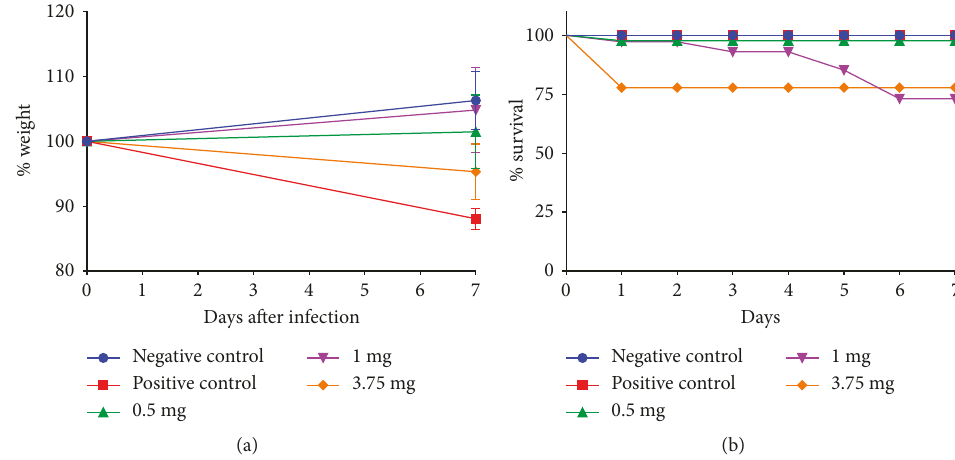
Figure 2: Graph of weight change and survival in infected mice: (a) graphic representation of the body weight (g) of C57BL/6 mice after 7 days postinfection with volcanic ash at concentrations of 0.5mg (green), 1mg (purple), and 3.75mg (orange); negative control (PBS, blue); and positive control (LPS, red). (b) Five groups of mice were uninfected (blue) and infected with volcanic ash at concentrations of 0.5mg (green), 1 mg (purple), and 3.75mg (orange) of volcanic ash or intraperitoneally infected with LPS (red), and survival were monitored daily for seven days. All data points for mice not infected or infected with LPS are in the same horizontal